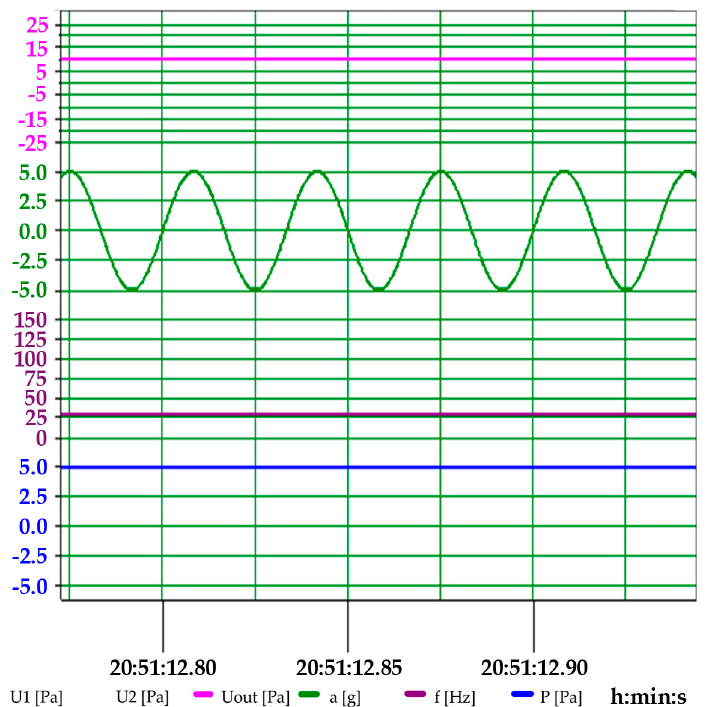
Figure 17. Waveforms of the experimental values of acceleration (a), pressure (p), and output signal (U out ) for dynamic acceleration with vibrations and with an amplitude of 5 g, frequency of f = 30 Hz, and pressure excitation of p = 5 Pa for the double-membrane transducer.